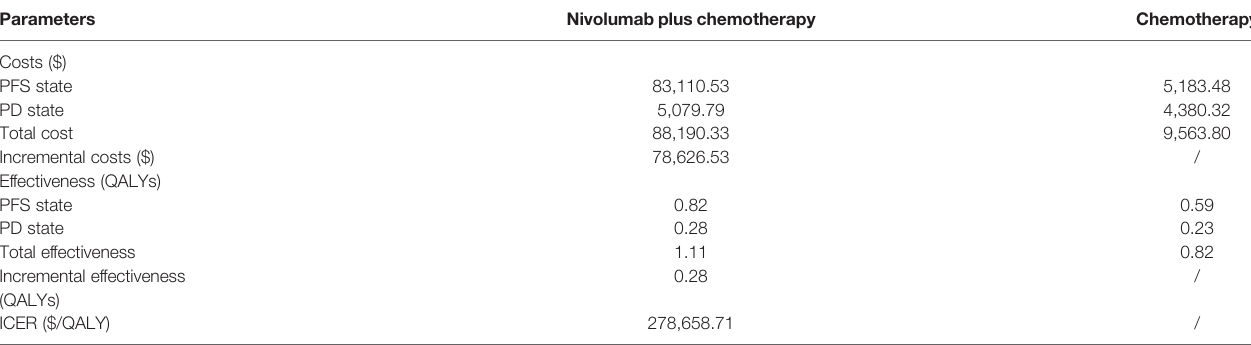
TABLE 3 | The cost and outcome results of the cost-effectiveness analysis. Parameters Nivolumab plus